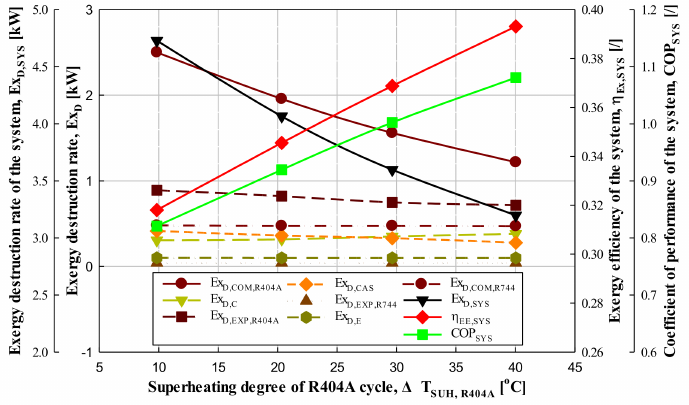
Figure 5. Exergy destruction rate, exergy efficiency and COP of the CRS with respect to superheating degree of R404A